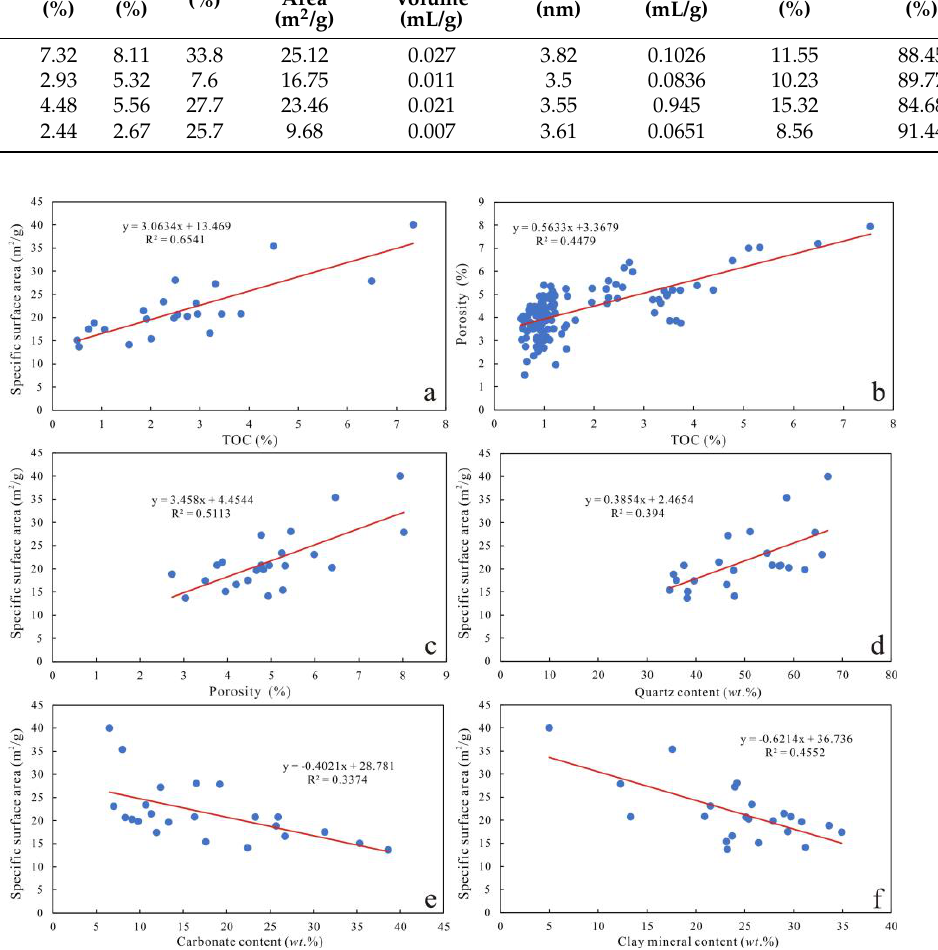
Figure 15. Relationships of contents of TOC: ( a , b ) porosity, ( c ) quartz content, ( d ) carbonate content ( e ), and clay mineral content ( f ), with the specific surface area of